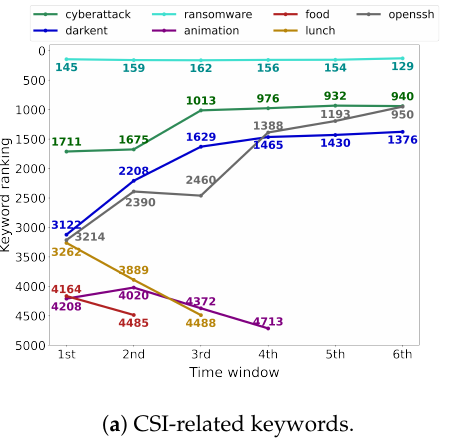
Figure 6. The change of keyword ranking over